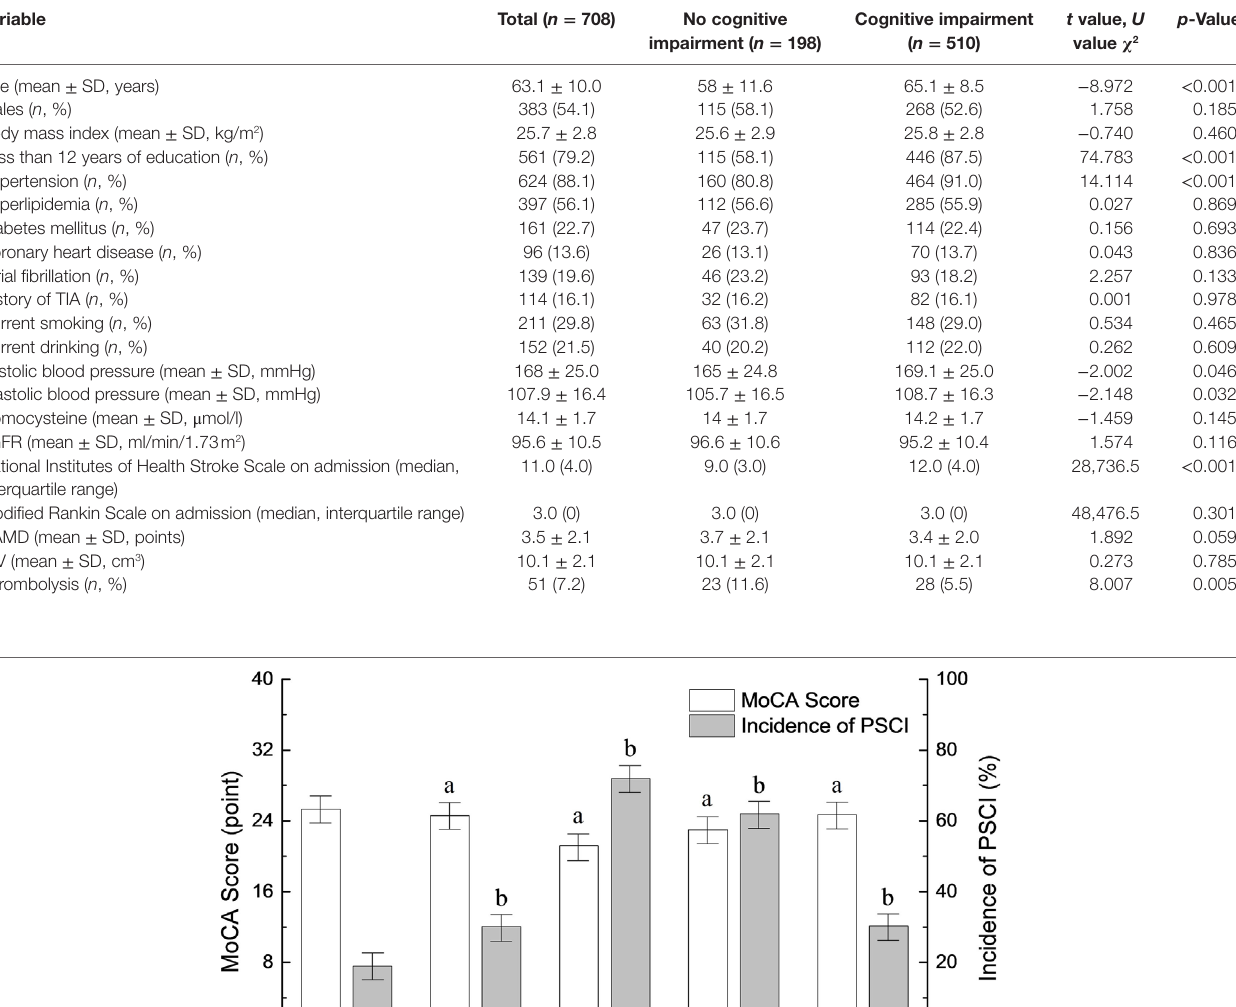
TaBle 1 | Comparison of baseline characteristics between patients with and without cognitive impairment 3 months after onset.